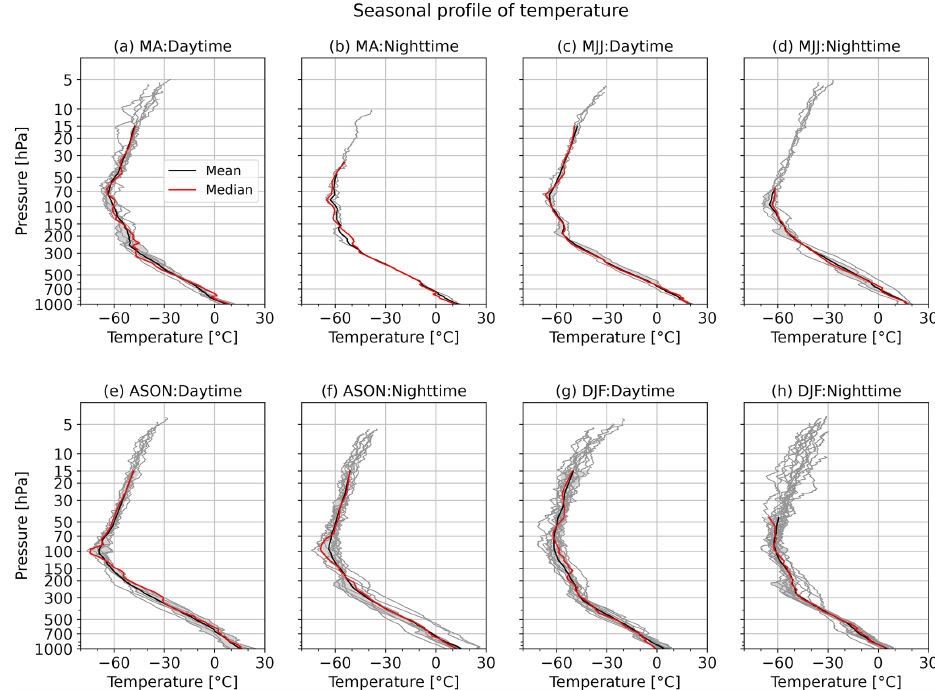
Figure 15. Seasonal profiles of iMS-100-GDP. Grey lines represent profiles for individual flights, red represents profile means, and black represents profile medians. Shading represents 25th–75th